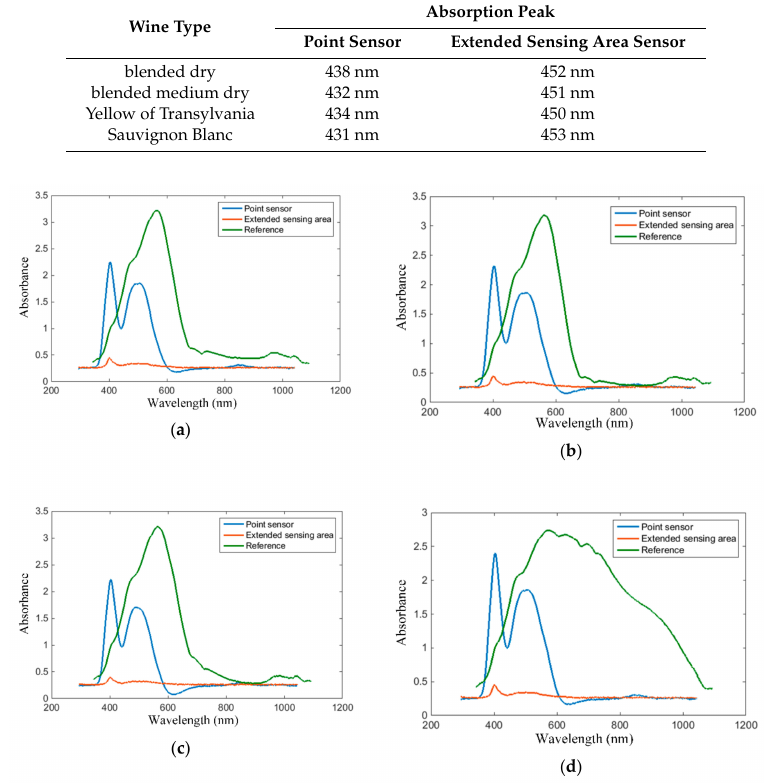
Figure 16. Red wine absorption spectra, acquired via the proposed intra-oral sensor implementations, with the blue line for the point sensor, orange line for the extended sensing area sensor, and green line for standard spectroscopic method, respectively: ( a ) blended medium dry, ( b ) blended medium sweet, ( c ) Feteasc ă Neagr ă , ( d ) Cabernet